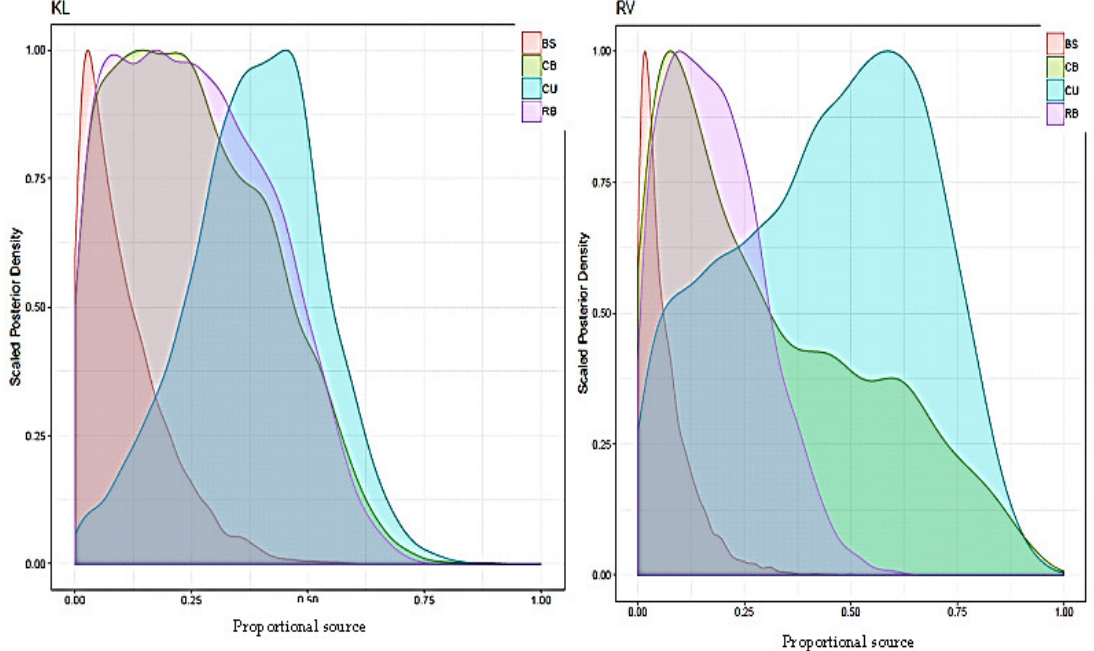
Figure 9. D-MixSIAR of the landuse from KL and RV tributaries where CU accounted for 38.4%, CB with 25.5%, RB with 25.6% and bushland with 10.5% for KL (left) and where CU accounted for 44.6%, CB with 31.0%, RB with 18.0% and BS with 6.4% of the total RV sediment (right).